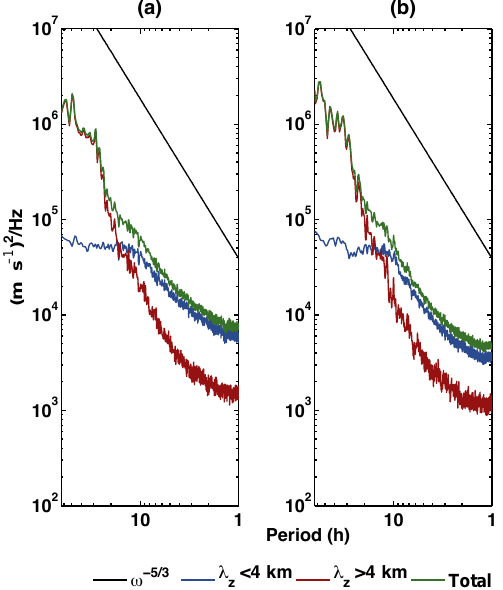
Figure 2. Power spectra of the zonal (a) and meridional (b) wind fluctuations obtained using Blackman–Tukey algorithm between 10 and 12km for the year 2013. The blue (red) line shows the spectra for wind fluctuations with the vertical wavelengths shorter (longer) than 4km and the green line shows the spectra for all